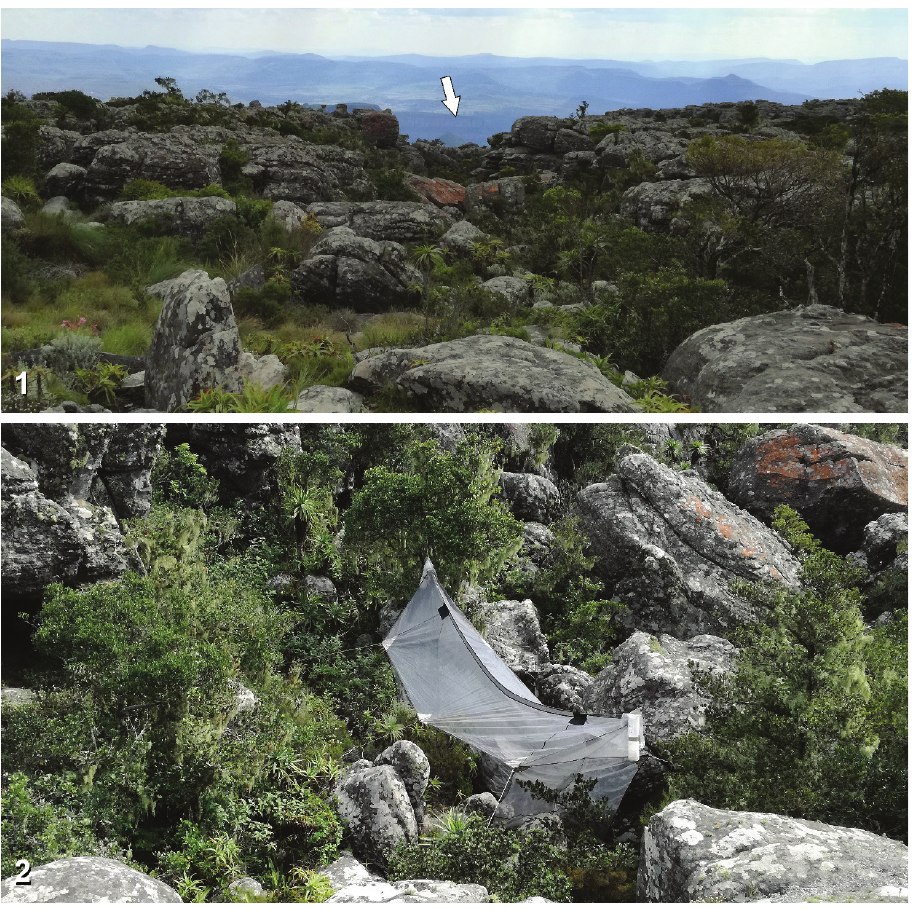
Figures 1, 2. Mariepskop study site 1 northern Escarpment Fynbos vegetation. Ravine indicated by white arrow 2 ravine with erected Gressitt & Gressitt-style Malaise